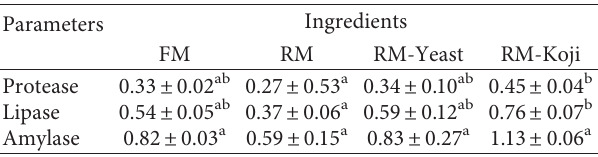
Table 5: Enzyme activity (U/mg) in the intestine of Japanese flounder fed test